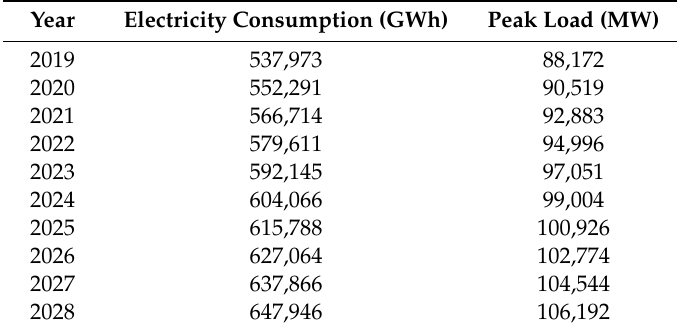
Table 4. Annual total consumption and peak load for 2019–2028, based on 2016 data.